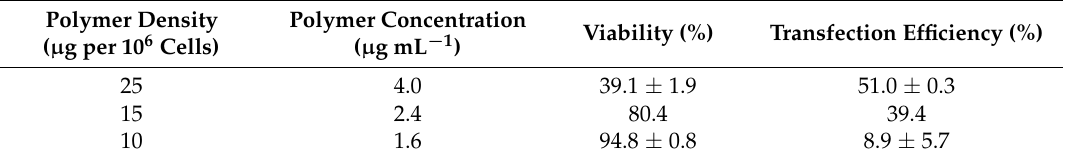
Figure 3. Influence of the “polymer density” (amount of nanostar added per 10 6 cells) on transfection efficiency and viability keeping the N/P ratio constant at a value of 10. (Total cells: 0.2 × 10 6 , transfection volume 2.2 mL (0.2 mL polyplex solution), bars represent percentages of transfected cells within the viable cell population (white: low producer, grey: middle producer, black: high producer), : viabilities. Shown are mean values ± SD, n = 2 for 50 µg, 25 µg and 10 µg polymer, n = 1 for the rest (data represent the averaged values of one experiment carried out in duplicate), SD are given for total transfection efficiencies and for viabilities.) Table 3. Comparison of the transfections in 6-well plates for increasing cell and polymer concentrations at constant cell number.